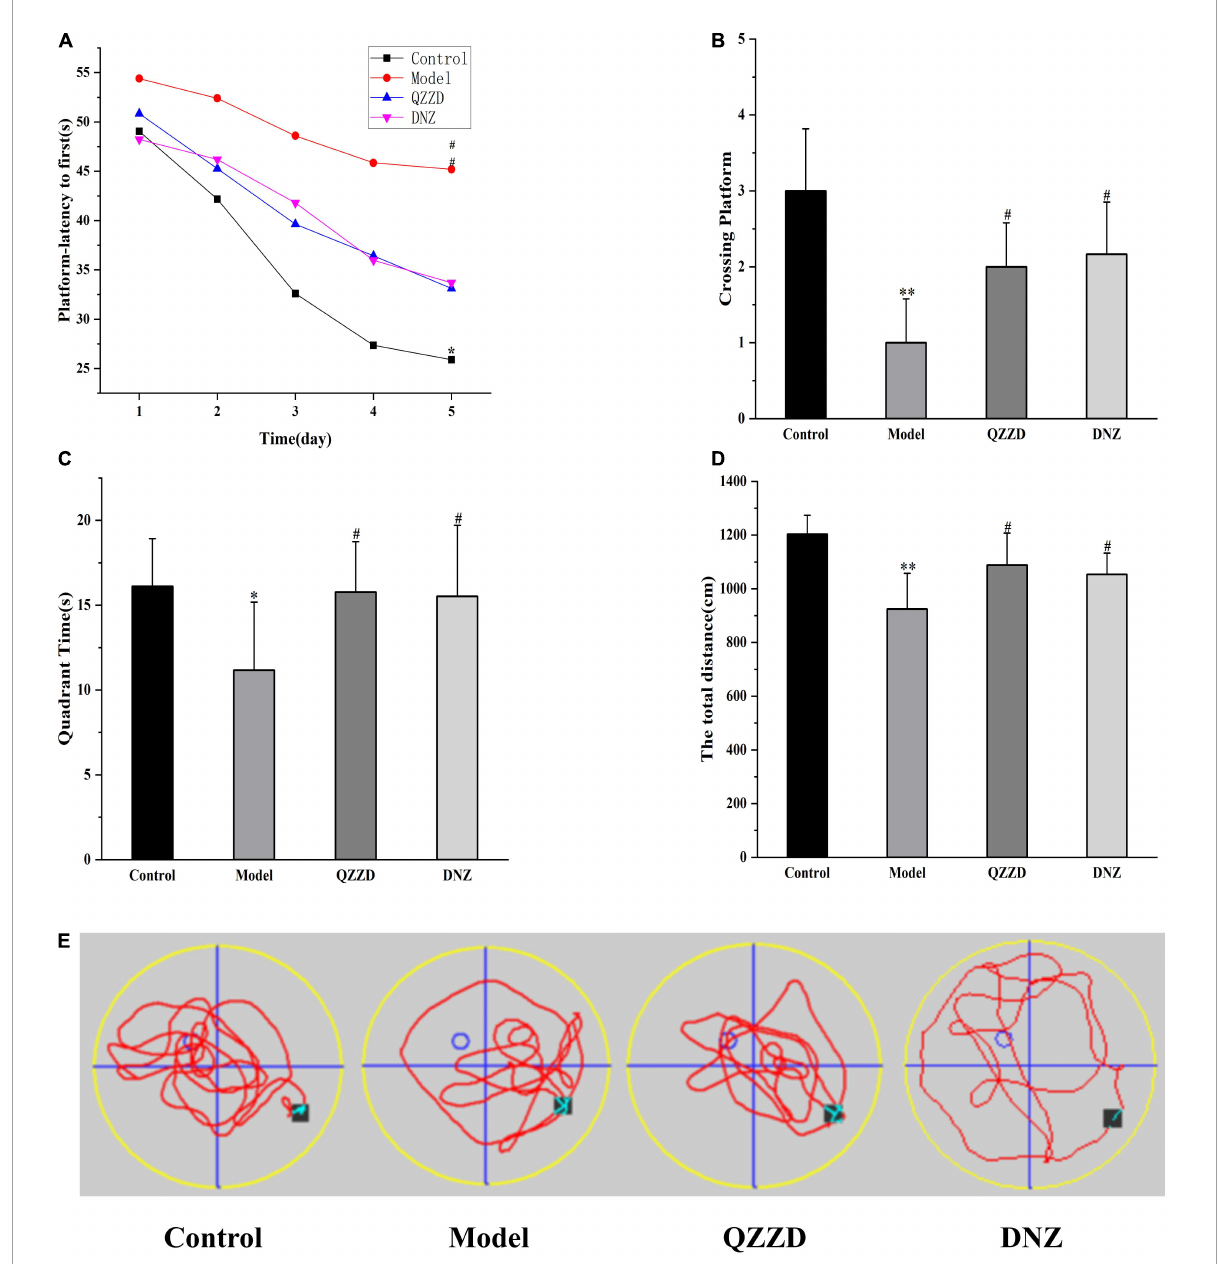
FIGURE9 Effects of QZZD on spatial learning and memory after 8 weeks of treatment. (A) Escape latency to hidden platform. (B) Number of crossing the original platform. (C) Time spent in the target quadrant. (D) The total moving distance. (E) Representative swimming path of mice. Values are expressed as mean ± SD, n = 12 in each group. ∗ p < 0.05, ∗∗ p < 0.01 compared with the control group; # p < 0.05 compared with the model